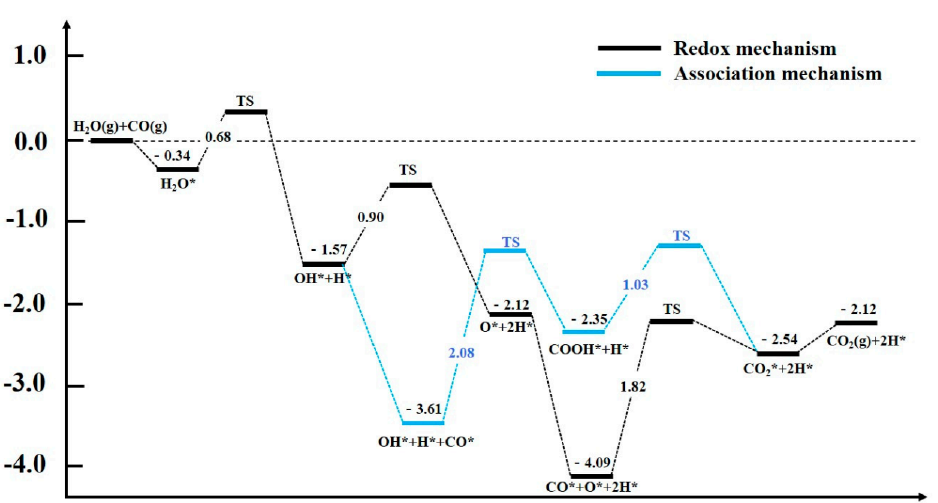
Figure 3. The comparison of CO 2 formation potential energy surface on Fe